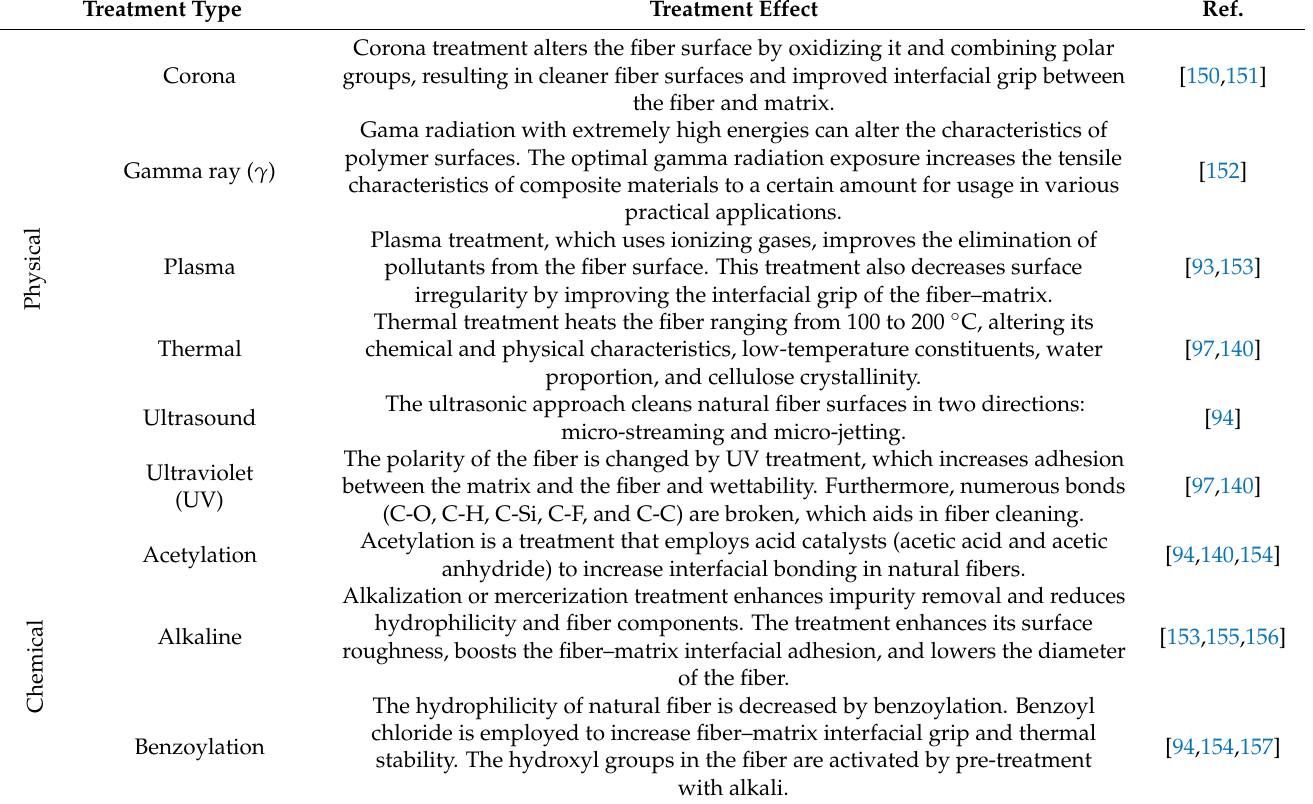
Table 5. Reason for physical and chemical treatment of natural fibers. Treatment Type Treatment